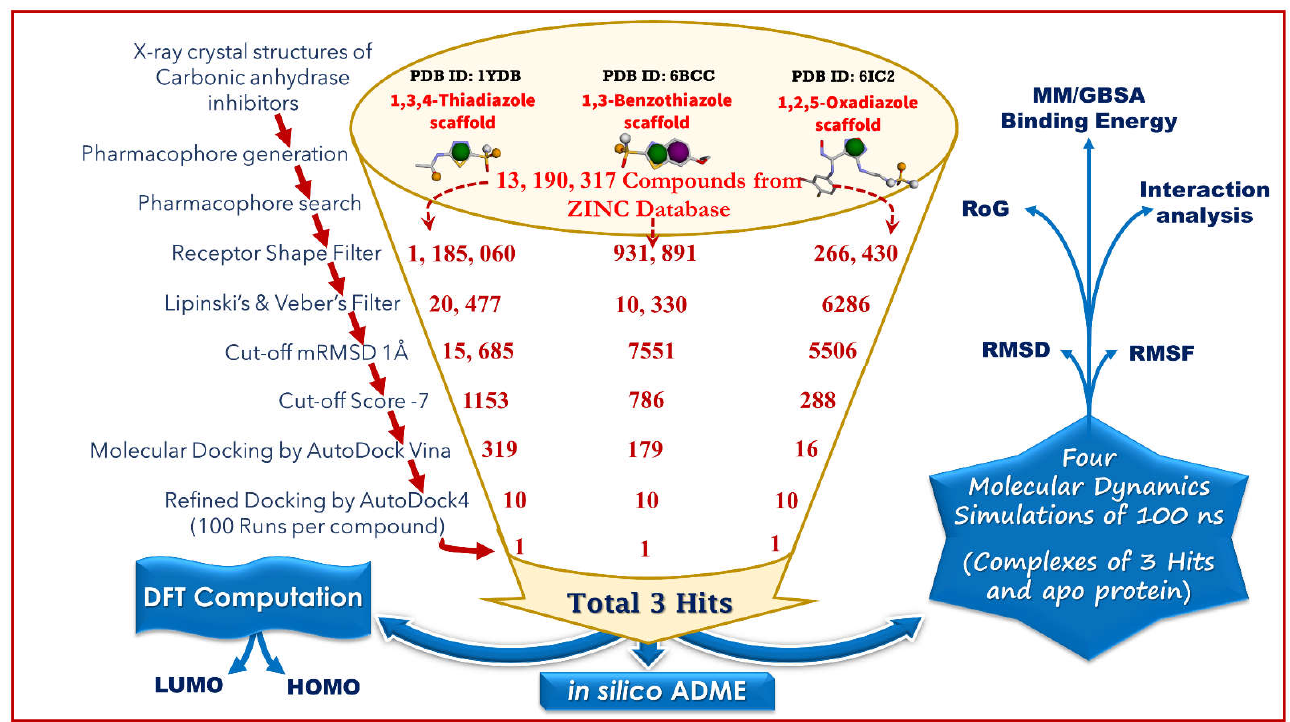
Figure 1. An illustration of the computational approaches implemented in this study.